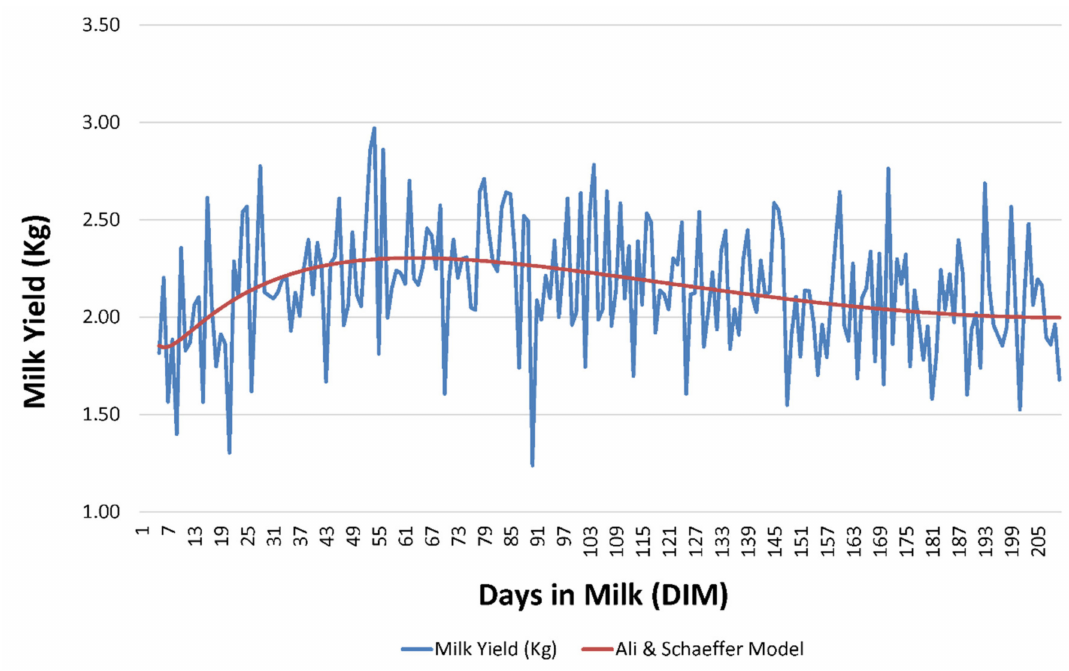
Figure 2. Graphical representation of the evolution of milk yield (Kg) and Ali and Schae ff er (ALISCH) model fit in